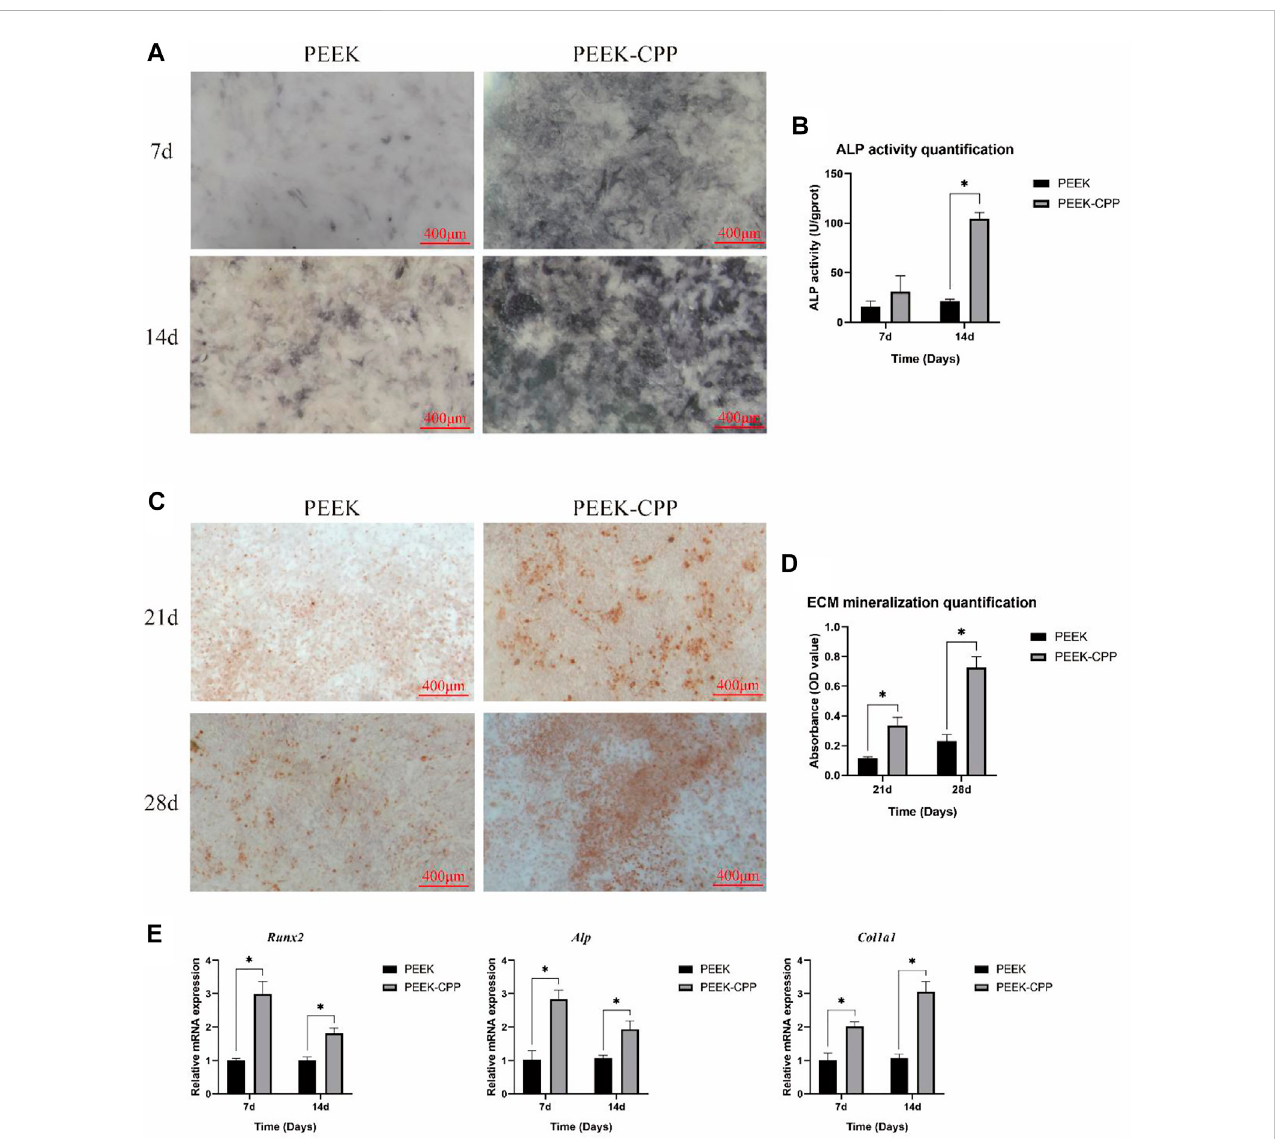
In vitro osteogenic differentiation. (A, B) Representative staining and quanti fi cation of ALP activity ( n = 3). (C, D) Representative ARS staining and quanti fi cation of ECM mineralization ( n = 3). (E) Expressions of osteogenic genes ( n = 3). * The asterisk indicates statistically signi fi cant differences between groups ( p <